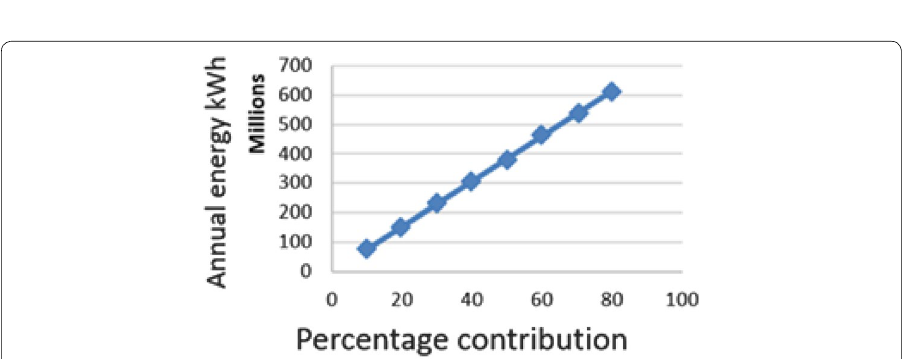
Fig. 10 Annual energy production versus percentage contribution of geothermal energy to the total energy demand